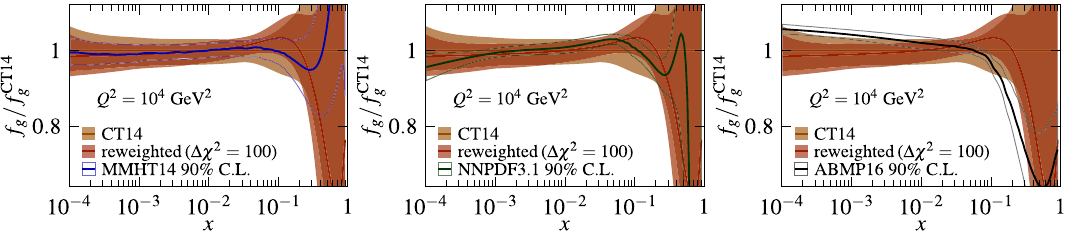
Fig. 5 Comparison of the NLO gluon PDFs of the original and reweighted CT14 sets with those from the MMHT14, NNPDF3.1 and 5-flavour ABMP16 analyses. The uncertainty bands of the latter have